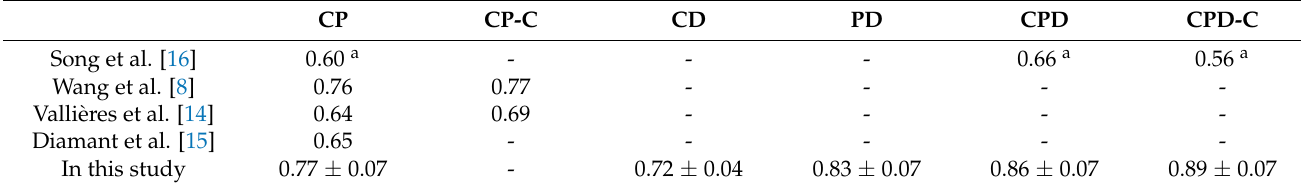
Table 1. Averaged AUC of test set compared to AUCs of other previous